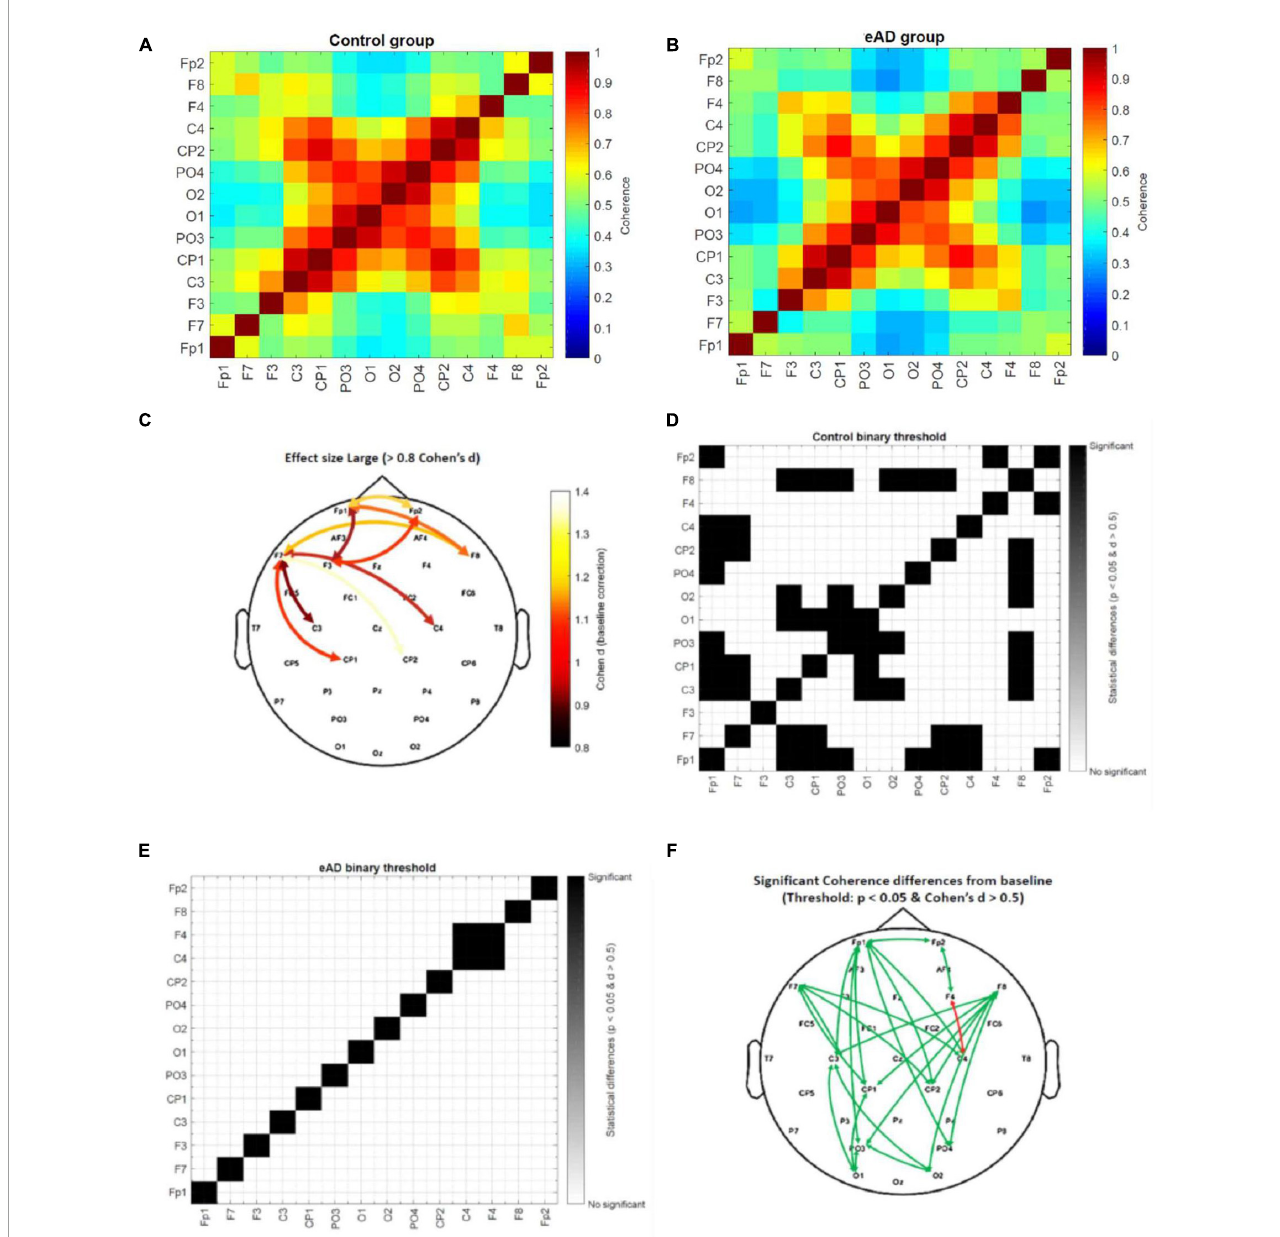
FIGURE5 Coherence beta (15–20 Hz) connectivity matrices from 0 to 300 ms. (A) Absolute coherence matrix for the control group, and (B) early Alzheimer’s disease (eAD) group. The color scale represents low coherence in blue and high coherence in red between a pair of electrodes. (C) Topographic distribution of electrode pairs with large value effect size ( > 0.8 Cohen’s d statistic). Threshold value matrix. (D) Matrix of control group and (E) matrix of eAD group. The color scale represents significant coherence differences for the baseline time (–750 to –450 ms) in black. In white, there is no difference in baseline time for the activity of the electrode pair, using as a threshold the p < 0.05 and Cohen’s d statistic > 0.5. (F) Topographic distribution of electrode pairs with significant coherence differences from baseline time by groups. The green arrow represents the control group, and the red arrow the eAD